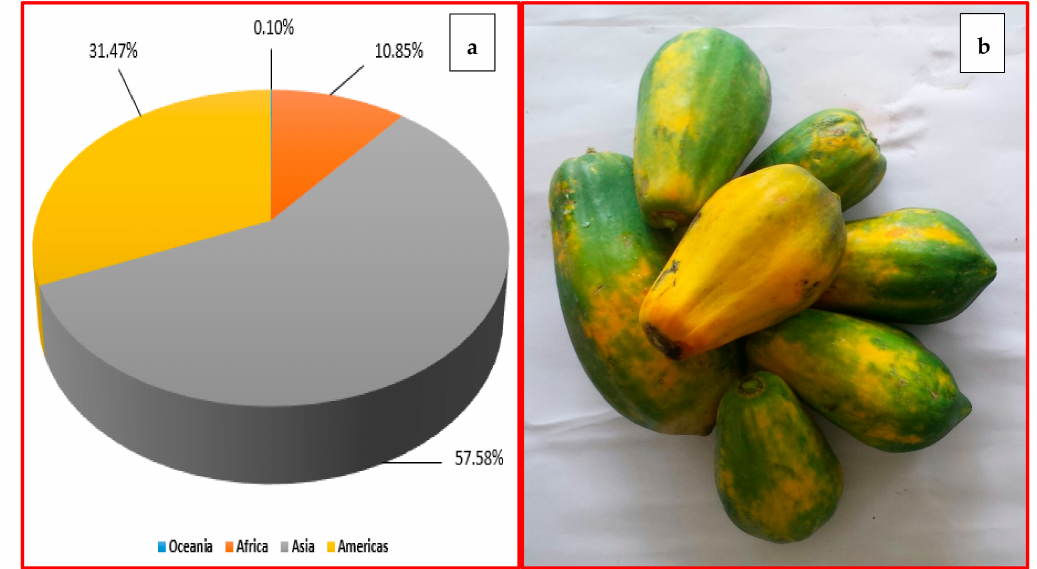
Figure 1. Pawpaw production share by region ( a ) in 2018 and pawpaw image ( b